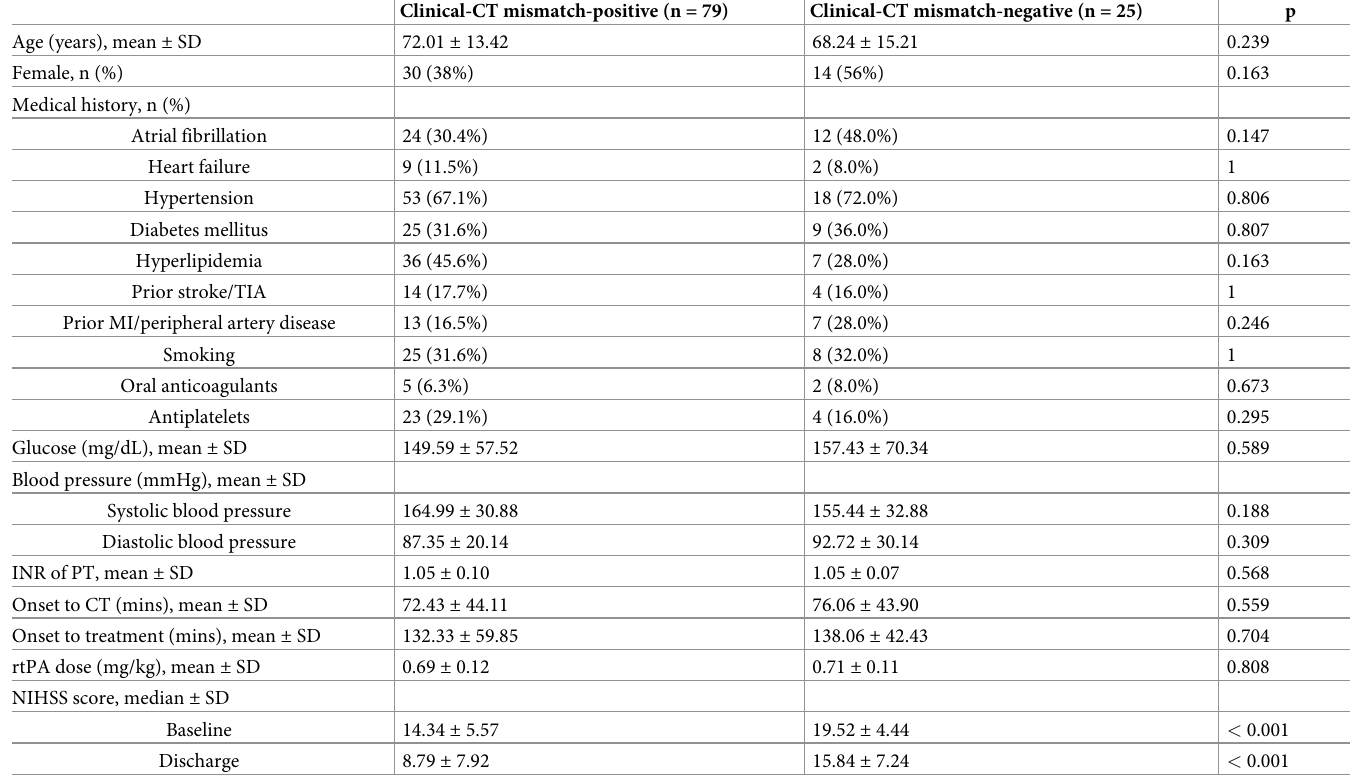
Table 1. Clinical characteristics of patients with cerebral infarction receiving intravenous thrombolysis as classified by clinical-CT mismatch.